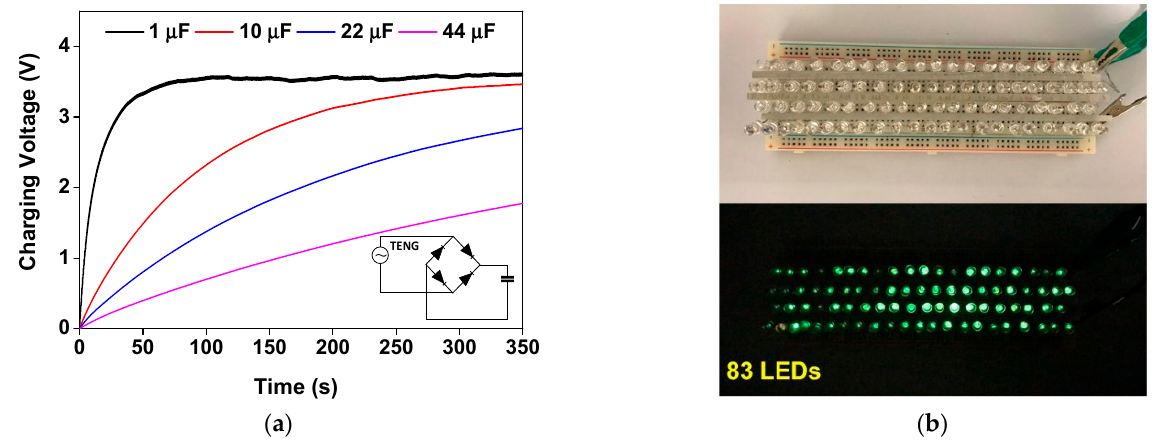
Figure 10. ( a ) Voltage profile of the NR@AgNP (1.5 mM CTAB) TENG to charge 1, 10, 22 and 47 µF; ( b ) the demonstration of lighting up 83 green LEDs connected in series by generated electrical power from the fabricated TENG.